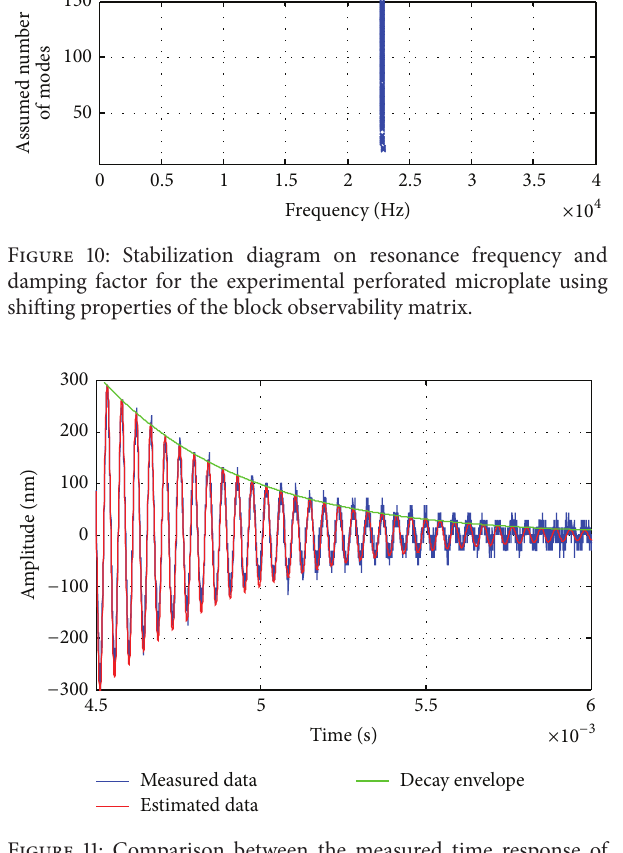
Figure 11: Comparison between the measured time response of the microplate (in blue) and the reconstituted time response of the microplate (in